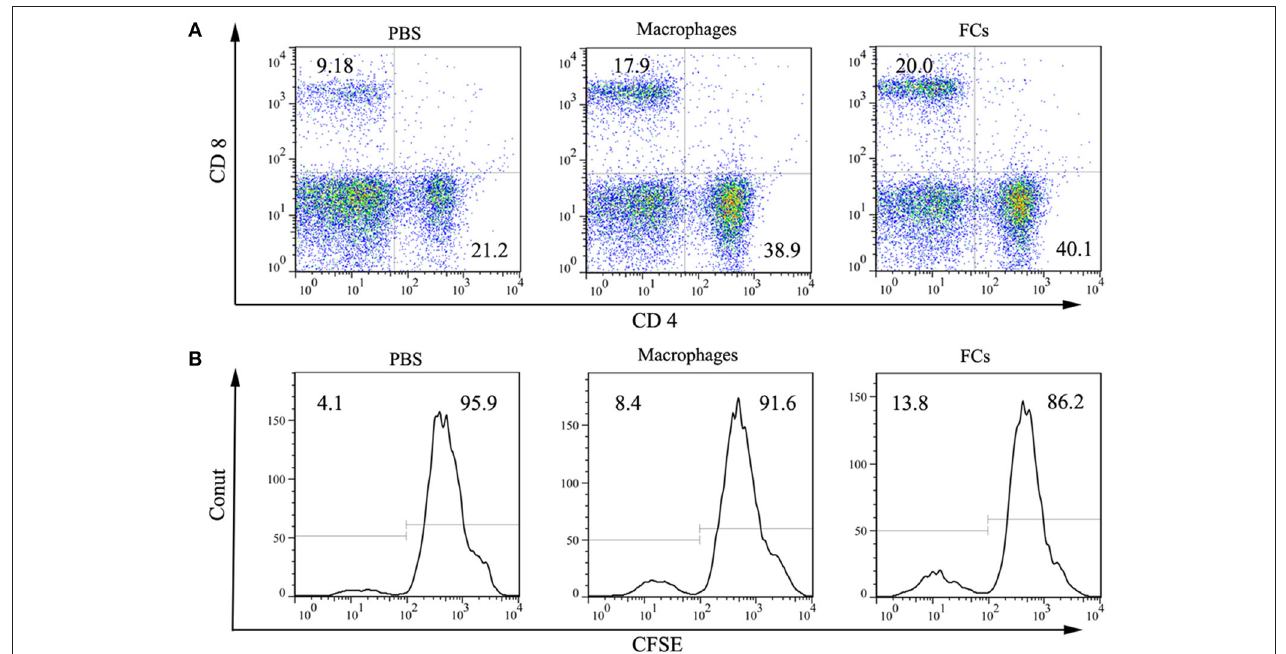
FIGURE 6 | FCs immunization induces cellar response. (A) Macrophages and FCs vaccines significantly increased CD4 + T cell and CD8 + T cell populations in spleen compared with those PBS immunized mice. (B) Total splenocytes were cultured in vitro in the presence of FCs or Macrophages. Proliferation of CD3 positive T cell was measured by CFSE with peaks reflecting cell